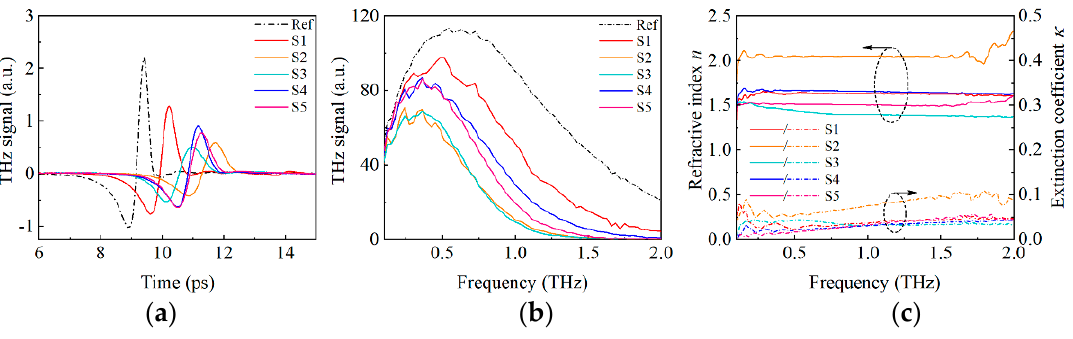
Figure 6. Terahertz spectroscopy test results of self-lubricating sliding bearing coating materials: ( a ) Time-domain spectroscopy; ( b ) Frequency-domain spectroscopy; ( c ) Complex refractive index.